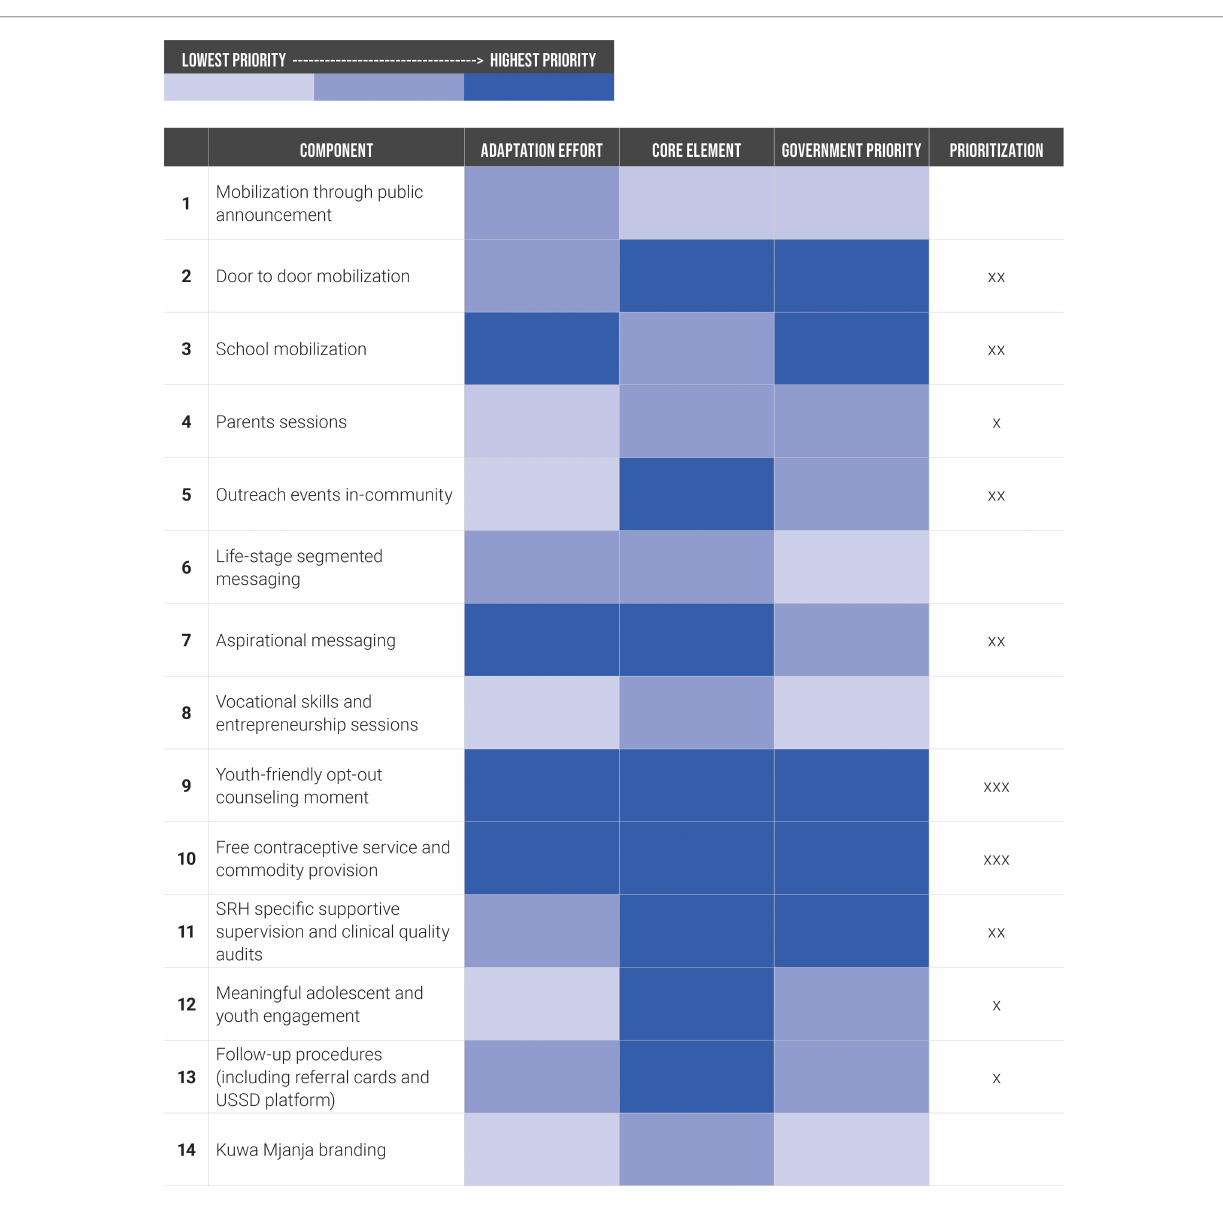
FIGURE 2 Kuwa Mjanja component prioritization during the institutionalization adaptation